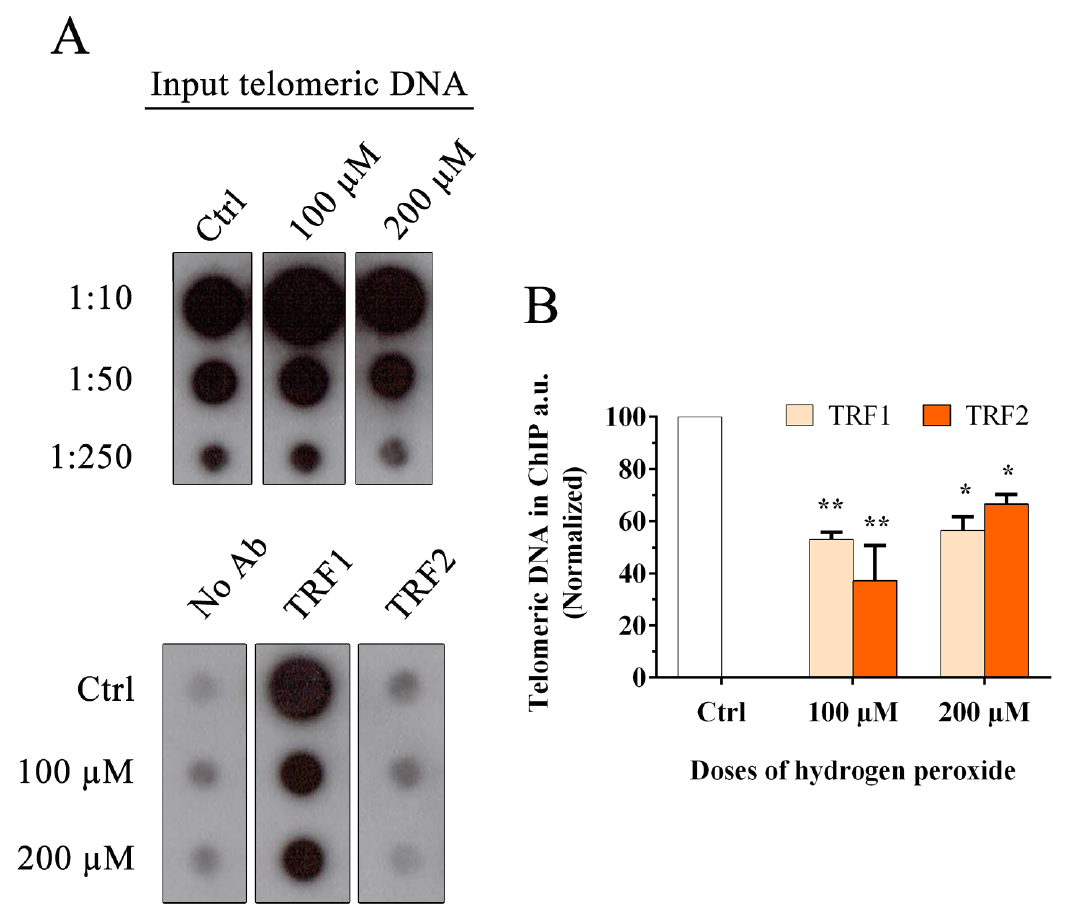
Figure 2. Chromatin immunoprecipitation and telomere dot-blot for TRF1 and TRF2. ( A ) Chromatin immunoprecipitation of MRC-5 cells after H 2 O 2 treatment (100 µM and 200 µM) with the indicated antibodies (TRF1 and TRF2) and the negative control (No Ab). Telomeric input signals are necessary for the quantification. For this analysis, a 1:10 input was used. ( B ) The histogram represents the data obtained by ChIP analysis at 48 h after treatment with two doses of hydrogen peroxide, 100 and 200 µM. Quantification of the immunoprecipitated telomeric sequences was performed after normalization to telomeric input signals. The data are normalized to the control value and are expressed as a percentage of the total telomeric DNA in arbitrary units (a.u.). The error bars denote the standard errors and were calculated using standard propagation rules. Statistical analysis was performed between treated and control samples. * p < 0.05; ** p < 0.01 by Student’s t-test.